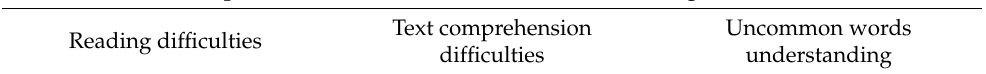
Table 2. List of the questions about dyslexic students’ issues, asked within the BESPECIAL questionnaire. Have You Ever Experienced One or More of These Issues during Your Academic Career?